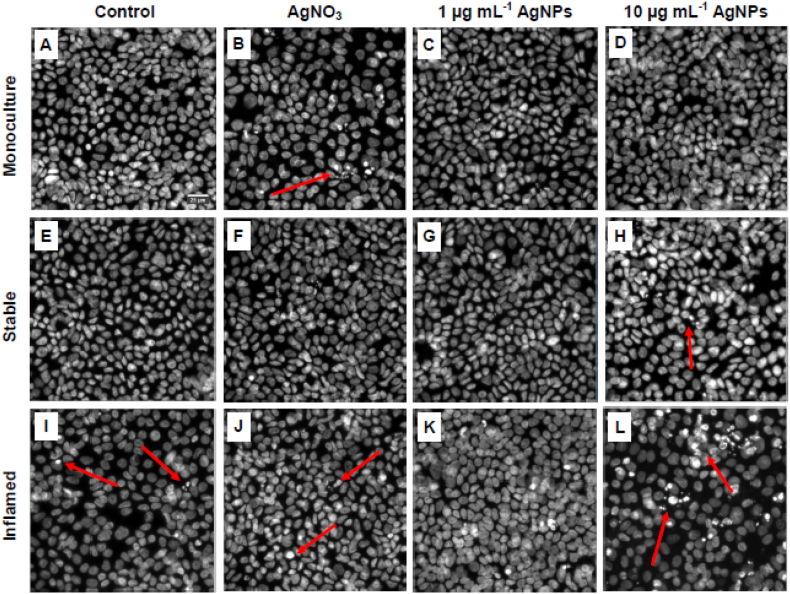
DAPI-stained Caco-2 nuclei after 24 h exposure to AgNPs or AgNO3.